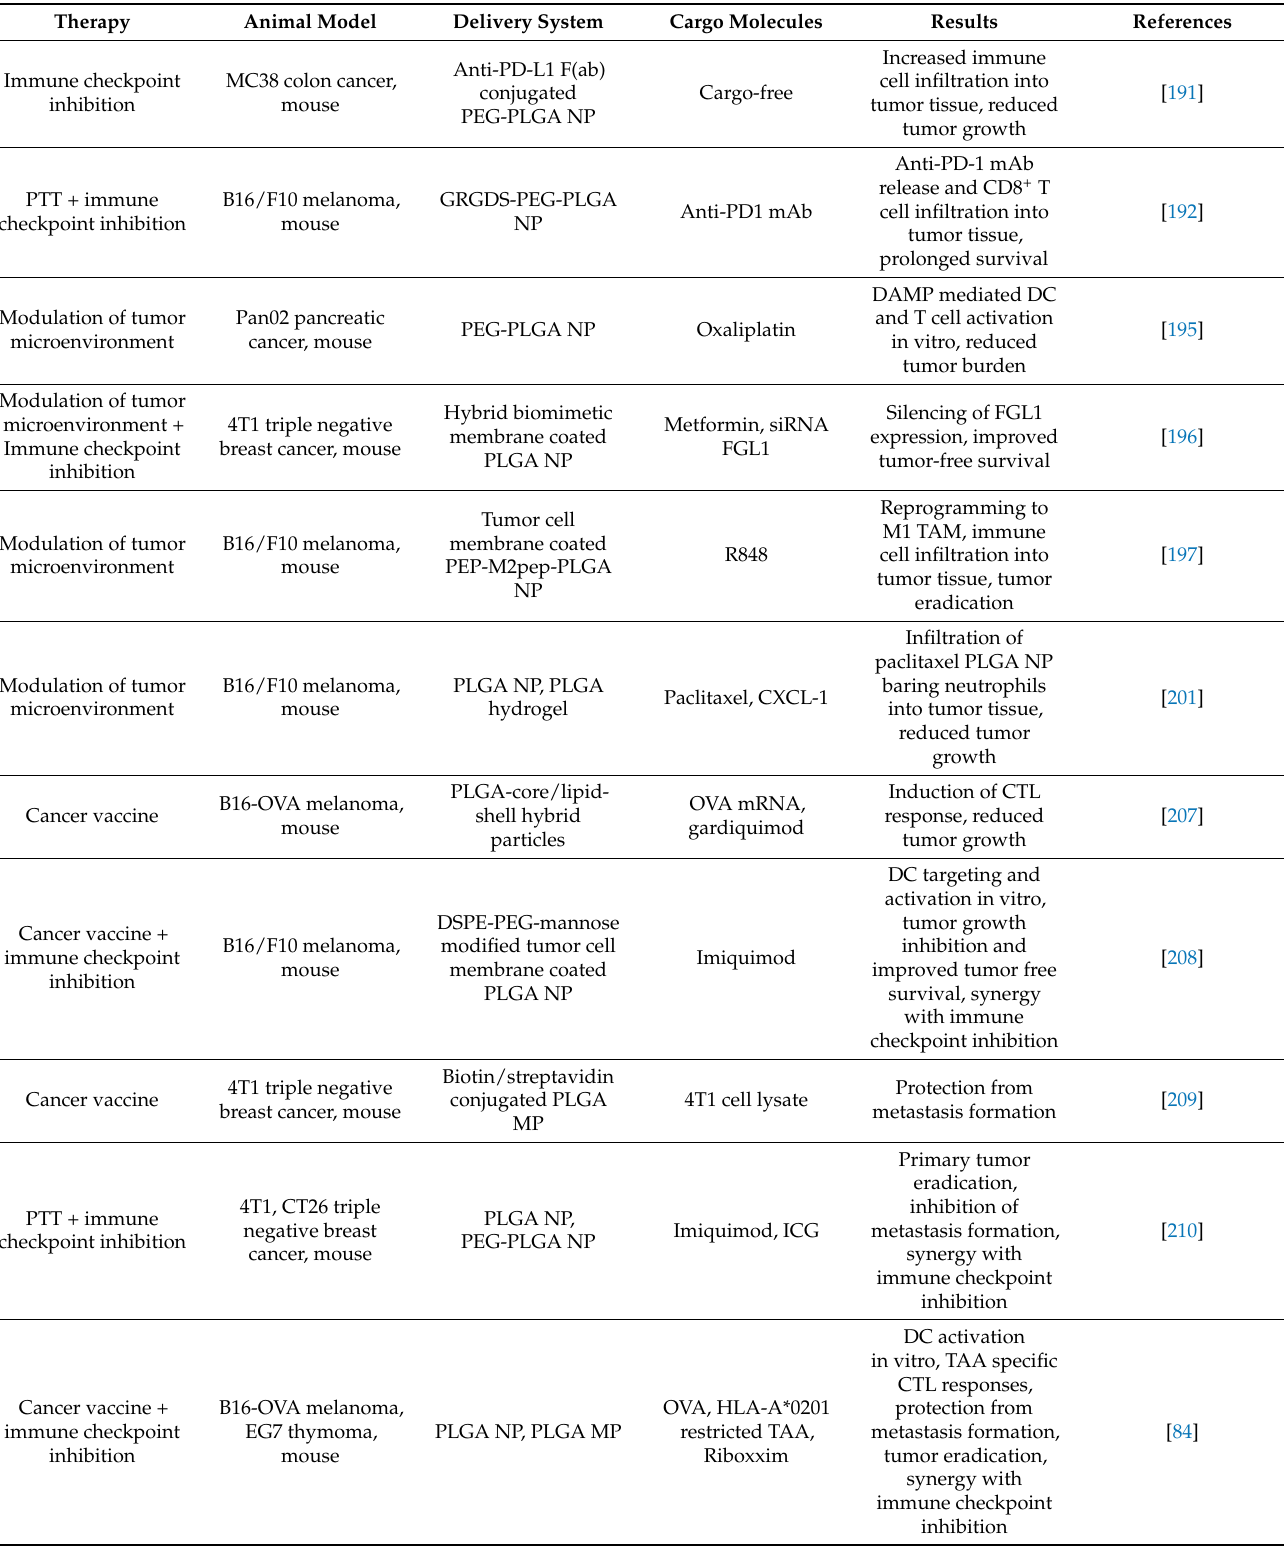
Table 5. Summary of PLGA-mediated cancer